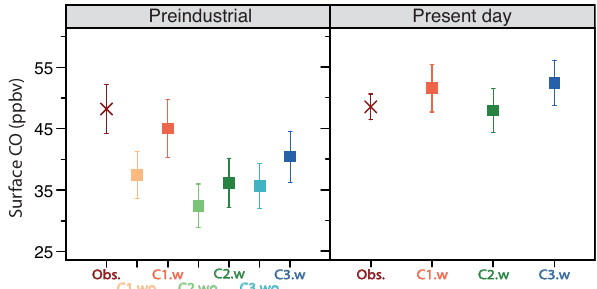
Figure 4. Comparison of model results with observations of CO surface concentrations (ppbv) over Antarctica for the preindustrial (1770s) and present-day (1990s) simulations. The maroon crosses represent observations from different sources for each time slice. Wang et al. (2010) measured ice-core CO concentrations at the South Pole of 48 ± 4ppbv for the year 1777 ( ± 110 years); the asso- ciated errors represent analytical uncertainties. The mean CO sur- face concentration measured at the South Pole by the NOAA Global Monitoring Division for the 1990s is 49 ± 2ppbv; the associated er- rors represent interannual variability. The squares represent values averaged over Antarctica from our model simulations tested with different chemistry and isoprene emission schemes for the prein- dustrial and present-day scenarios. Simulations are as described in Table 2; colors are as in Fig. 2. Error bars associated with the model results represent ± 1 standard deviation of the spatially averaged mean